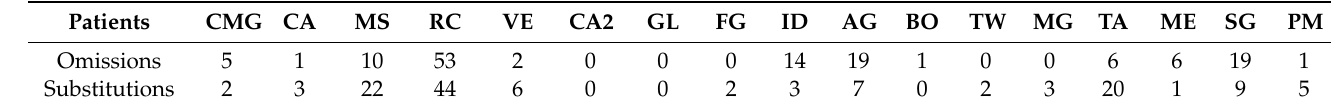
Table 5. Number of reading errors for the 17 patients in the standard spaced condition (unspaced). The patients who showed a prevalence of substitution errors in reading words and pseudo-words are highlighted in bold.